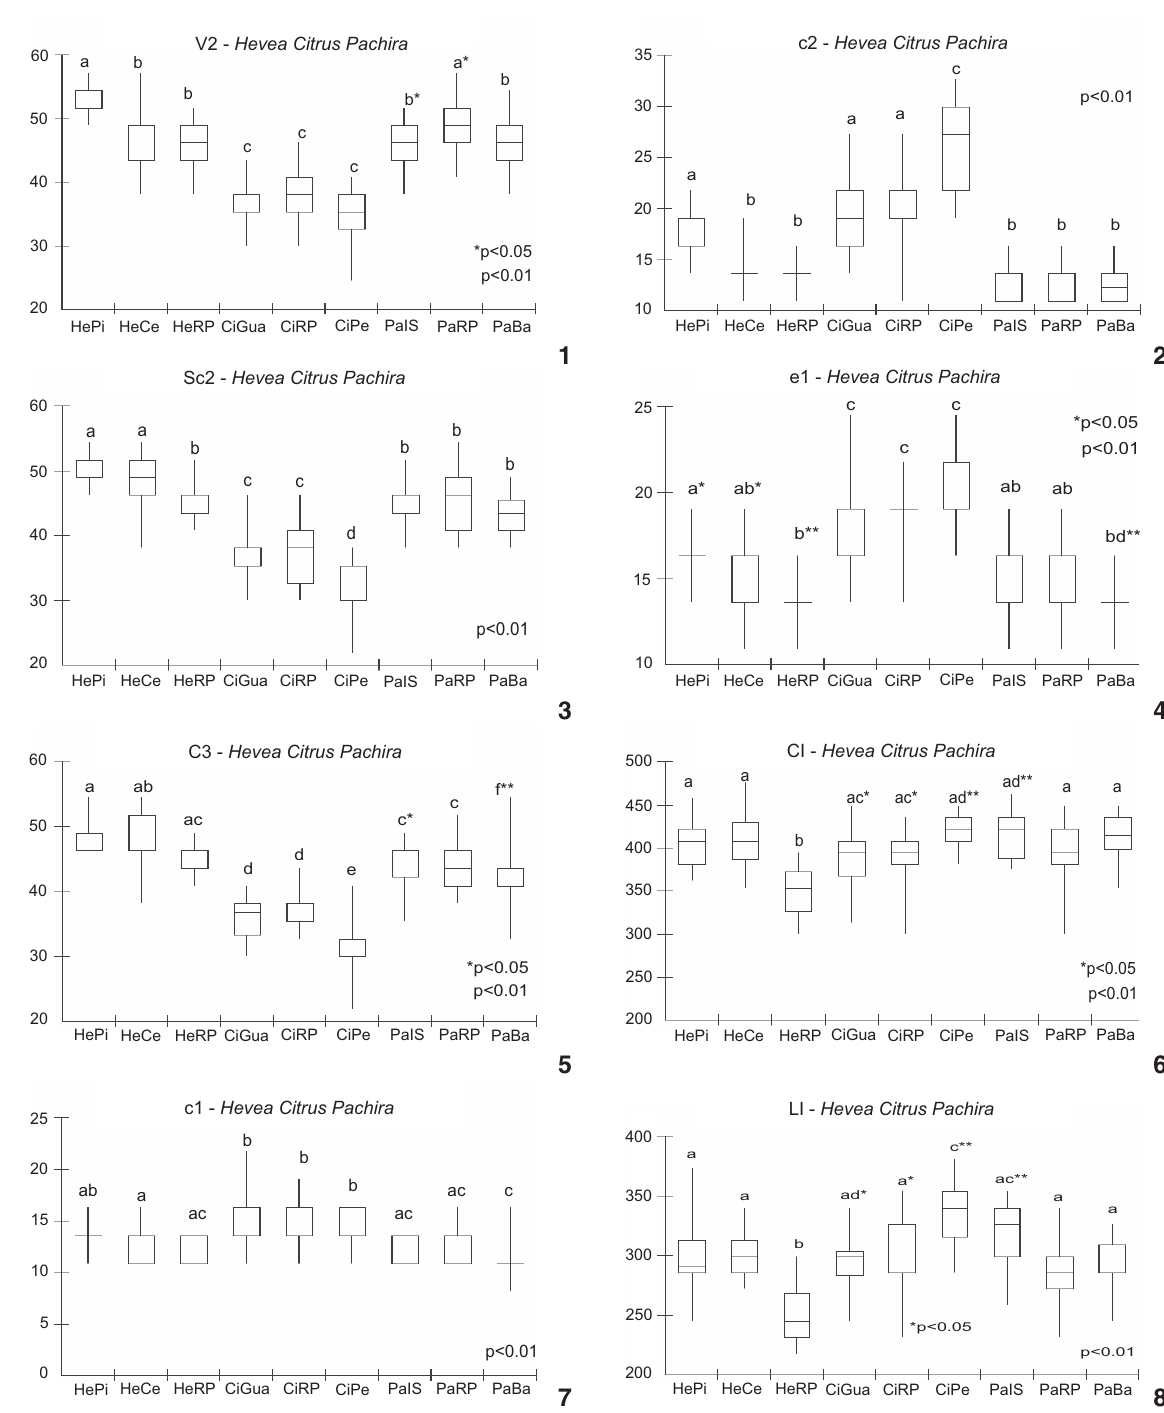
Figuras 1-8. Distribuição do comprimento das setas (µm) v2 , sc2 , c3 , c1 , c2 , e1 (1-6), comprimento do idiossoma (7) e largura do idiossoma (8) de fêmeas de E. banksi oriundas de H. brasiliensis , Citrus sp., e P. aquatica nas localidades de Piracicaba, Cedral e São José do Rio Preto: HePi, HeCe e HeRP; sobre Citrus sp., nas localidades de Guapiara, São José do Rio Preto e Recife: CiGua, CiRP e CiPe; e